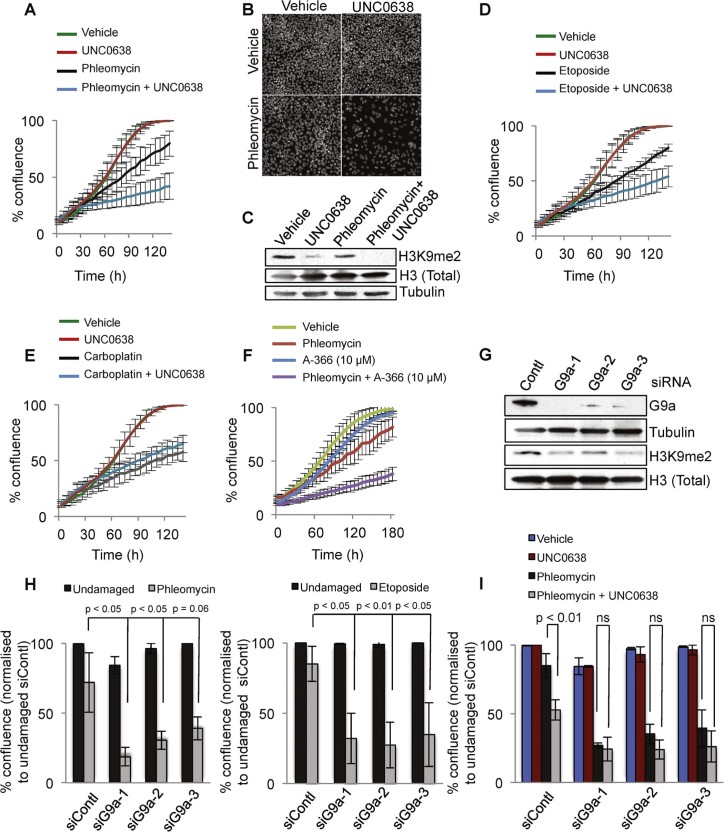
G9a inhibition potentiates the anti-tumour activity of DSB-inducing agents. (A) Growth curves for U2OS cells show that co-treatment of UNC0638 (1 µM) with phleomycin (1 µM) significantly inhibits tumour cell growth compared to cells treated with phleomycin alone. (B) Representative images of DAPI stained cell nuclei at the end-point of the proliferation assay are shown. (C) Western blot analysis reveals a reduction in levels of histone H3K9 dimethylation (H3K9me2) upon UNC0638 treatment. Total levels of histone H3 and tubulin served as loading controls. (D and E) Growth curves of U2OS cells demonstrate that co-treatment of UNC0638 (1 µM) hypersensitised tumour cells to etoposide (100 nM) but not carboplatin (15 µM). At the same concentrations of phleomycin and etoposide, UNC0638 did not adversely affect the cell growth of non-tumorigenic RPE1 and MRC5 cells (see Supplementary Fig. S3). (F) Structurally distinct chemotype of G9a small-molecule inhibitor, A-366, similarly hypersensitises U2OS cells to phleomycin. (G) Western blots confirm G9a depletion and corresponding reductions in H3K9 dimethylation (H3K9me2) upon treatment of U2OS cells with three independent siRNAs (siG9a-1, 2, 3) compared to control siRNA-transfected cells (siContl). Tubulin and total histone H3 were used as loading controls. (H) Depletion of G9a, the target of UNC0638 and A-366, with three independent siRNAs (siG9a-1, 2, 3) hypersensitises U2OS cells to phleomycin (1 µM) and etoposide (100 nM) compared to control siRNA-transfected cells (siContl). Histograms depict % confluence of cells at the endpoint of the proliferation assays. (I) Histograms provide the % confluence of cells at the endpoint of the proliferation assays with indicated treatments of U2OS cells showing that UNC0638 does not further increase the hypersensitivity of G9a depleted cells (siG9a-1, 2, 3) to phleomycin (1 µM) supporting the effects of UNC0638 being via G9a inhibition. Error bars correspond to standard deviations (SDs) of three independent experiments. Non-significant p-values are represented as ns.